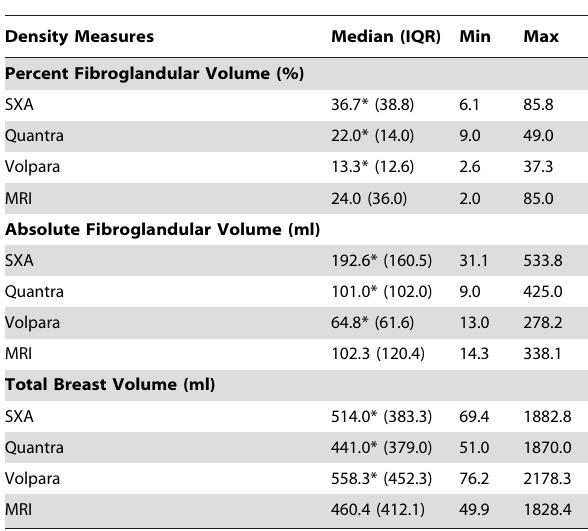
Table 2. Density measures for study participants by method